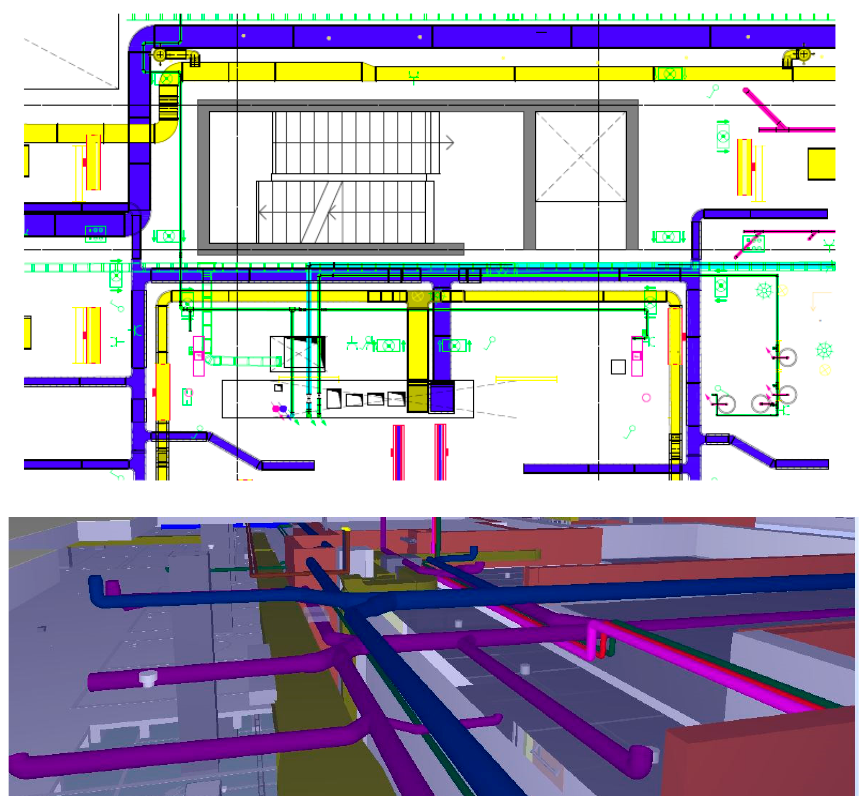
Figure 10. MEP coordinated planimetry obtained from the BIM model ( above ), and the associated 3D model view ( below ). Final execution project (PED).